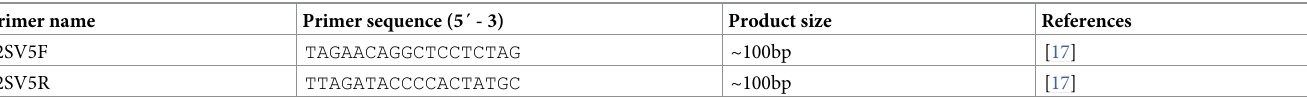
Table 2. Details of the primer sequences used in the study. Primer